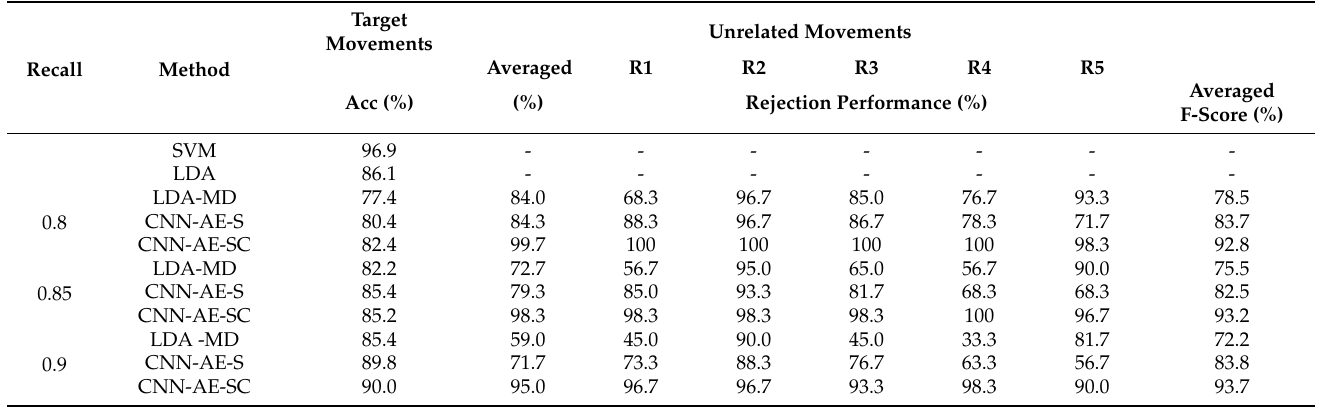
Table 1. Recognition accuracies of target and unrelated movements and F-score when the recall factor is set to 0.8, 0.85, and 0.9,